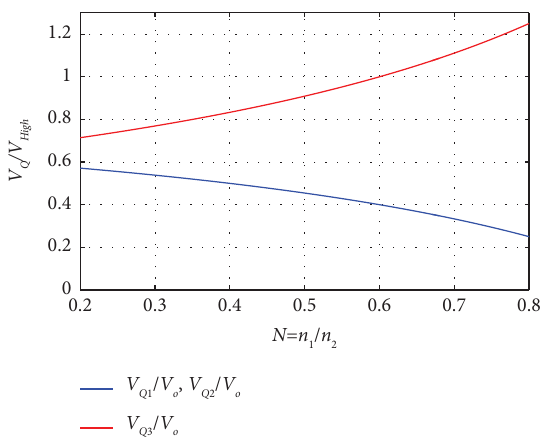
Figure 7: Peak voltage versus duty cycle ( D